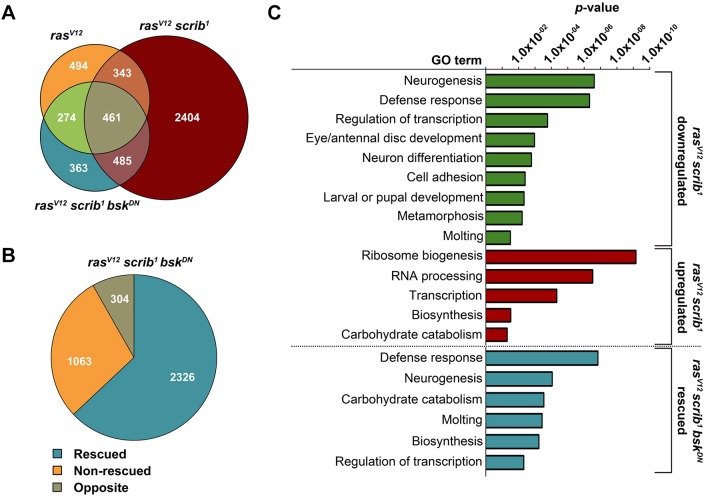
Malignant rasV12scrib1 tumors exhibit a unique gene expression profile. (A) Venn diagram shows marked increase in number of genes whose expression changed ≥1.5-fold relative to control (P<0.05) in the EAD bearing rasV12scrib1 (in total 3693 genes) compared with rasV12 alone (1572 genes). Inhibition of JNK signaling (rasV12scrib1bskDN) reduced the number of deregulated transcripts to 1583. (B) Blocking JNK activity rescued 63% of deregulated genes (blue) in rasV12scrib1 tumors, with rescue defined as ≥1.5-fold change in expression from rasV12scrib1 towards control levels. Non-invasive rasV12scrib1bskDN tumors also exhibited a unique set of genes (8%) regulated in a direction opposite to rasV12scrib1 mosaic EAD. (C) Distinct functional GO clusters enriched among genes ectopically expressed (red) or downregulated (green) in rasV12scrib1 tumors and among those rescued in rasV12scrib1bskDN (blue) identified by DAVID. For genes falling into individual GO categories, see supplementary material Table S1.